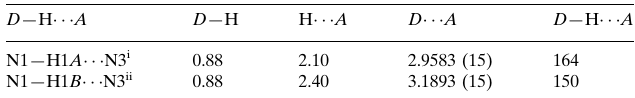
Hydrogen-bond geometry (A˚ , (cid:3) ).